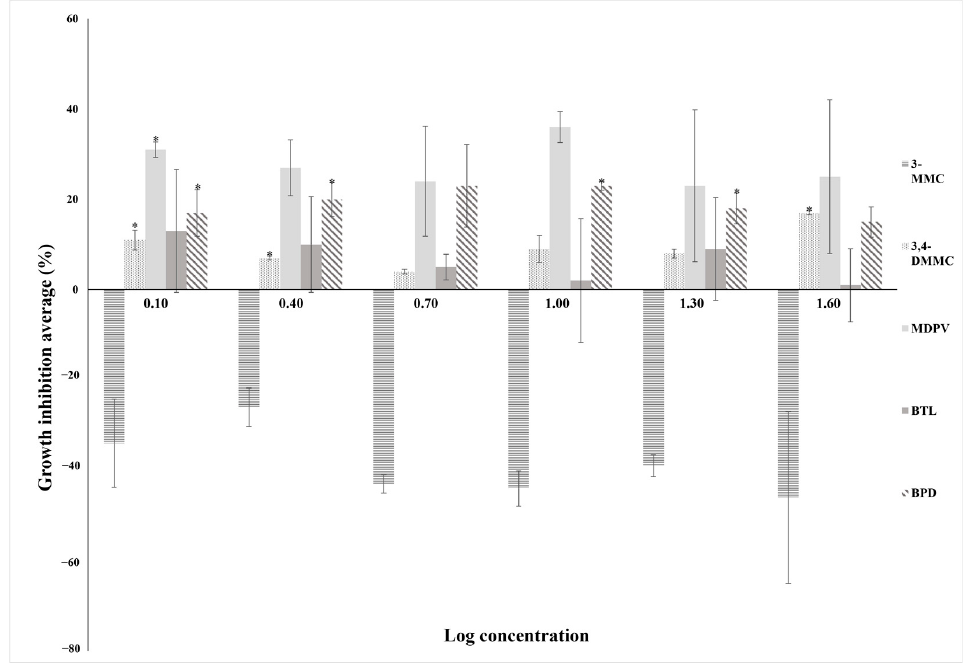
Figure 2. Percentage of growth inhibition vs log concentration in Tetrahymena thermophila after 28 h of exposure to the five SC (BPD, 3-MMC, 3,4-DMMC, MDPV and BTL) at the six concentrations tested. The results are expressed as the mean ± standard deviation (SD) obtained from three independent experiments. (Asterisks (*) represent significant differences compared to the control). Table 2. Percentage of growth inhibition on Tetrahymena thermophila after 28 h of exposure to BPD, 3-MMC, 3,4-DMMC, MDPV, and BTL.